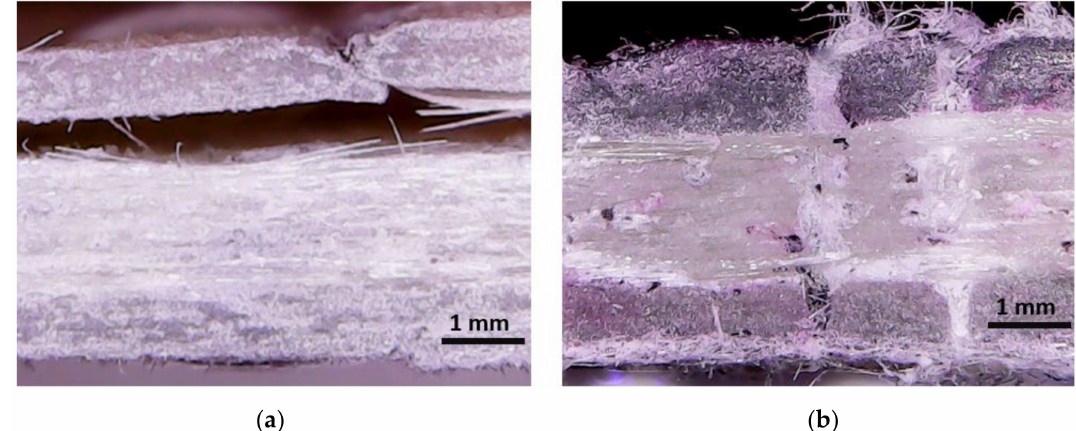
Figure 11. Damage after 26 J impact in: ( a ) an unstitched laminate where the delaminations reach the specimen edges; and ( b ) cross-sectional view of stitched laminate where delamination was avoided.